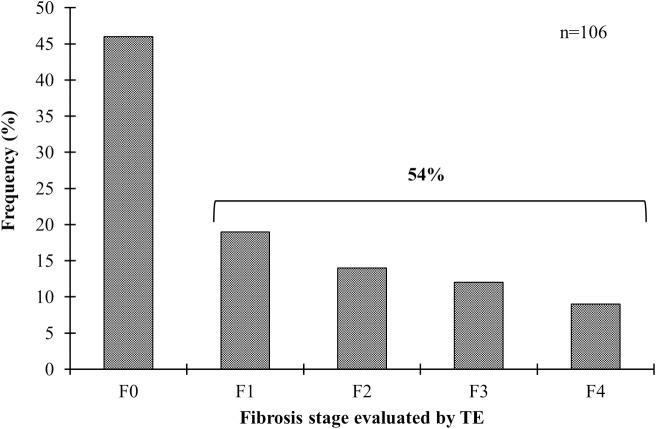
Stage of fibrosis based on LSM by using TE.F1: initial fibrosis; F2: intermediate fibrosis; F3: advanced fibrosis; F4: liver cirrhosis.